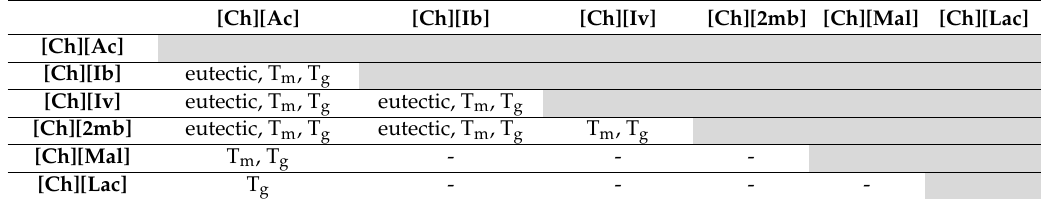
Table 2. Overview of the studied binary phase diagrams. (Shading provided to avoid double entries and non-mixtures.)